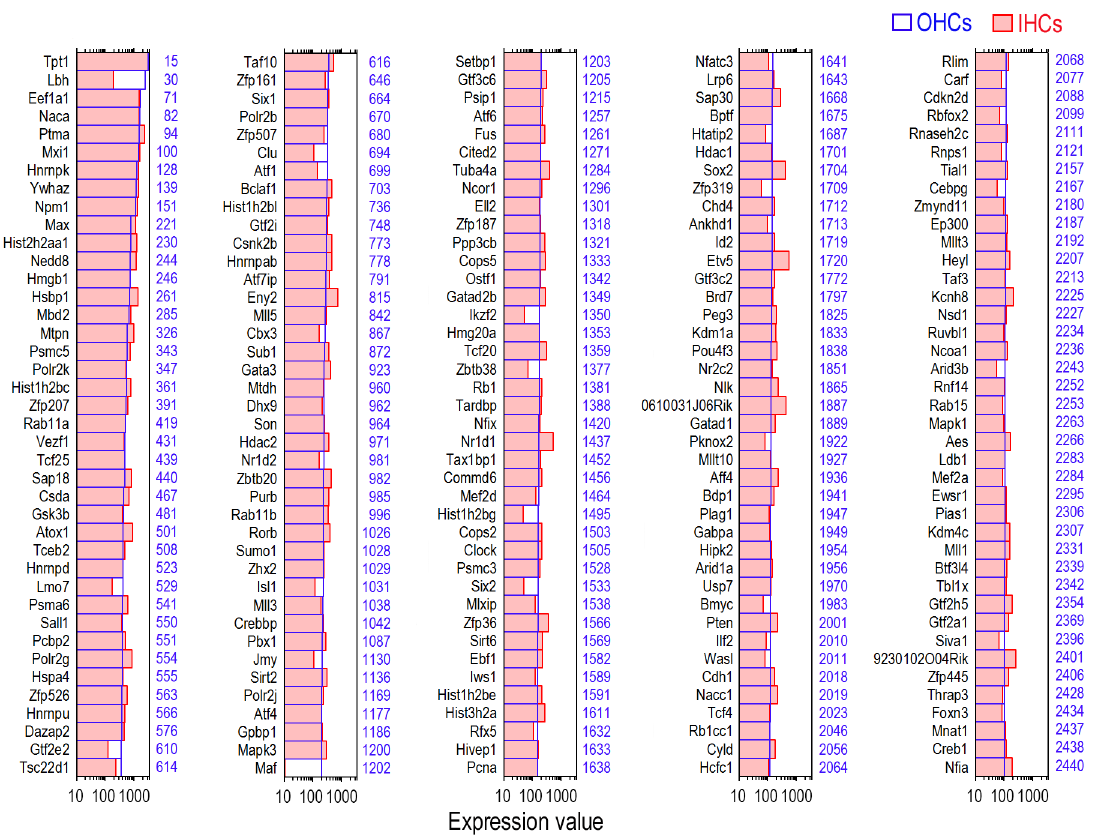
Fig 2. Expression levels of the top 200 TF genes in adult OHCs (in blue) in descending order. For comparison, the expression value of the same genes in adult IHCs (in red) is also presented. Color-coded numbers on the right side of each panel represents the abundance ranking of the each TF among 17,711 transcripts considered to be expressed in adult